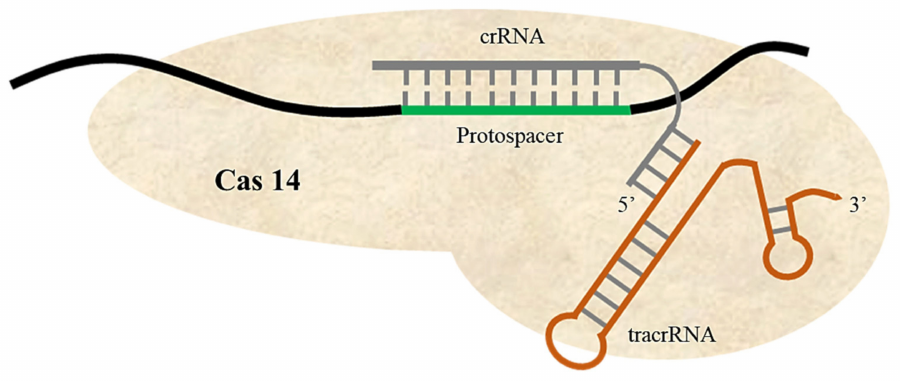
Figure 5. Schematic diagram of CRISPR/Cas14. This system utilizes Cas14 enzyme with two RNAs: crRNA and tracrRNA. It binds only ssDNA, and cuts without requiring a PAM site for